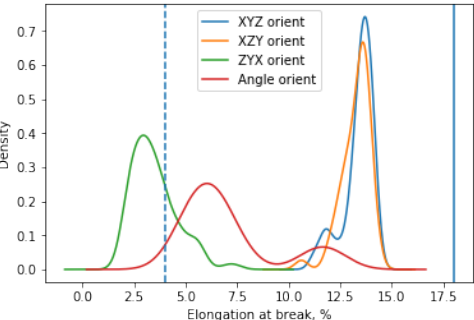
Figure 6. Distribution of elongation at break for different orientations based on kernel distribution estimation. The straight solid (18% for the XYZ orientation) and dashed lines (4% for the ZYX orientation) correspond to the values from the EOS Balanced